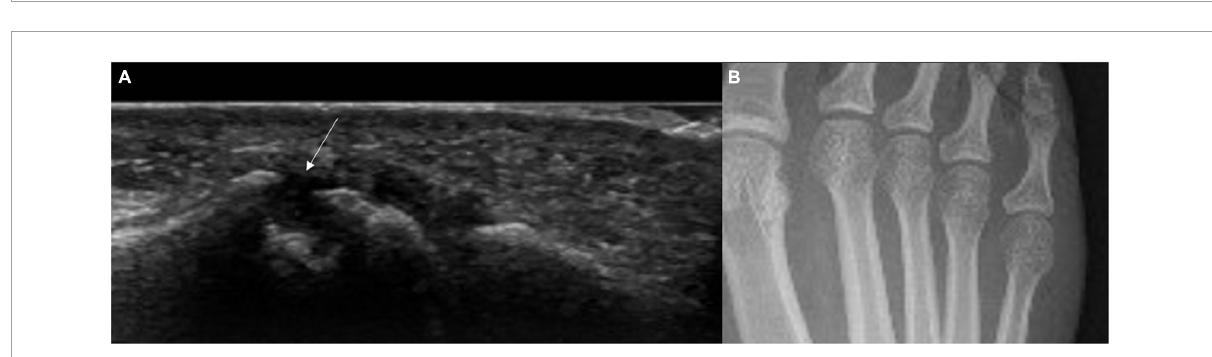
FIGURE2 US bone erosion (not detected by x-rays) in the 5th MTP joint in an individual with high titre ACPA and non-specific MSK symptoms. (A) Longitudinal US scan of the lateral aspect of the 5th MTP joint. The white arrow indicates the presence of bone erosion. (B) Correspondent feet x-rays showing no bone erosions in the 5th metatarsophalangeal joint. This patient presented with non-specific musculoskeletal symptoms and high titre anti-CCP